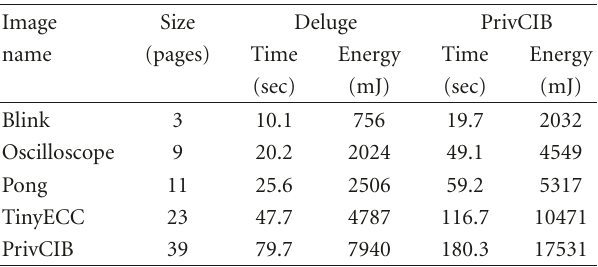
Table 1: Program images and transfer time/energy using Deluge and PrivCIB.